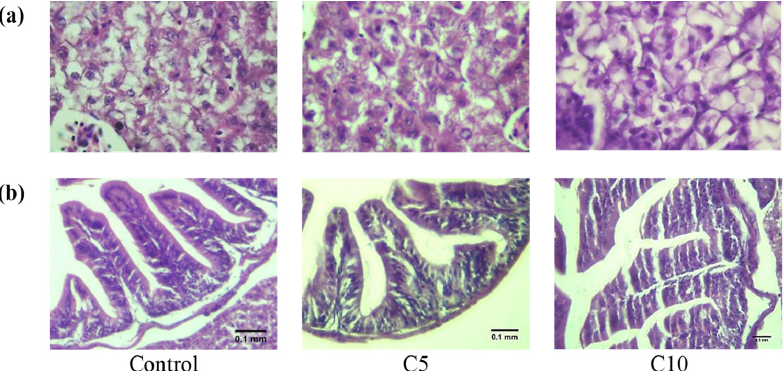
Figure 3. Histological sections show a normal structure of ( a ) liver and ( b ) intestine of red tilapia fish (H&E staining).